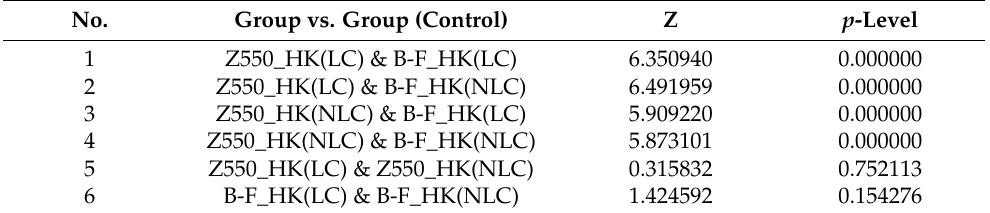
Table 2. Wilcoxon test results. Significance of the differences in the microhardness of the tested materials in the control group. LC—light-cured surface of sample (top side of sample), NLC—non- light-cured surface (the bottom side of a sample), HK—Knoop